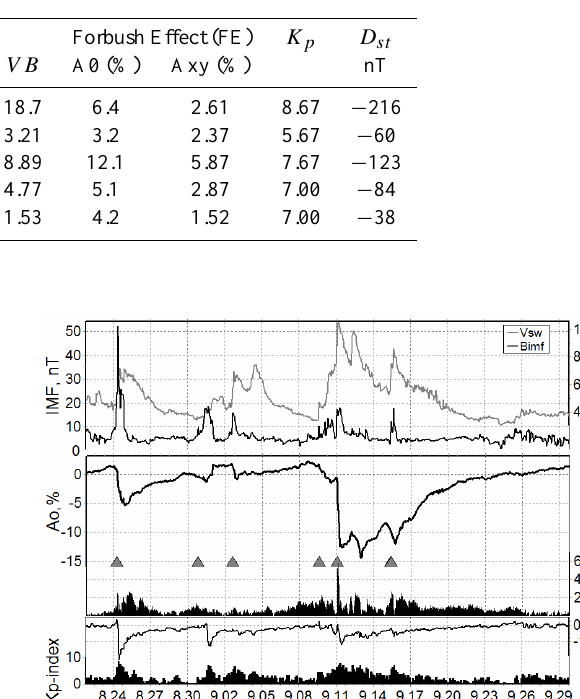
Figure 2: Behavior of the CR density ( А 0) and vector of equatorial component of the anisotropy ( Ах y) for 10 GV rigidity CR during September 9-13, 2005. Vertical vectors represent the north-south component of the CR anisotropy. Triangles indicate the timing of the shock arriving. The thin lines connect the equal time moments on the density curve with the vector diagram.